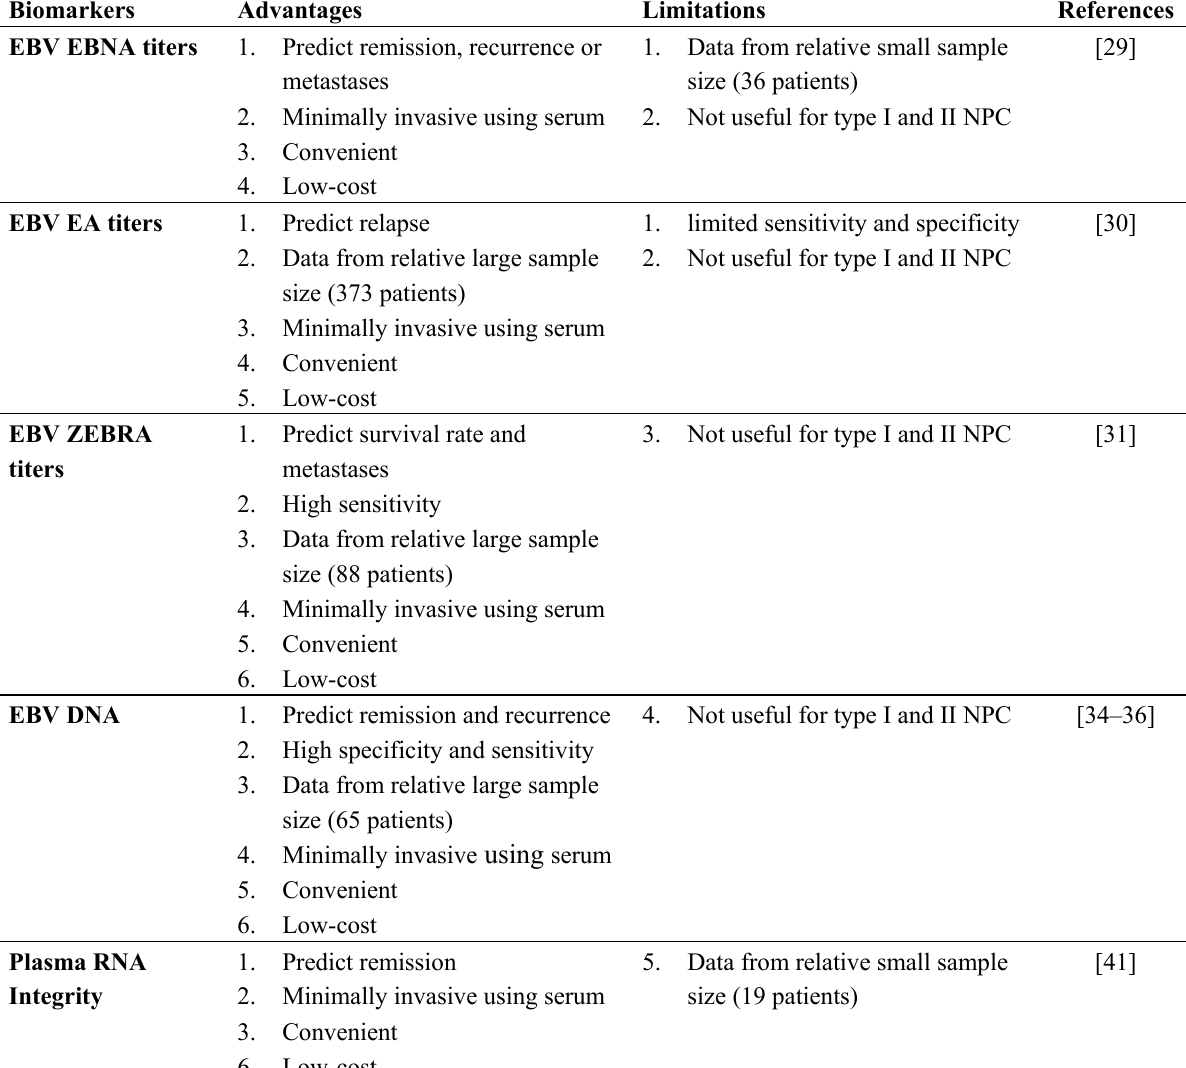
Table 1. Biomarkers for monitoring responses of NPC to